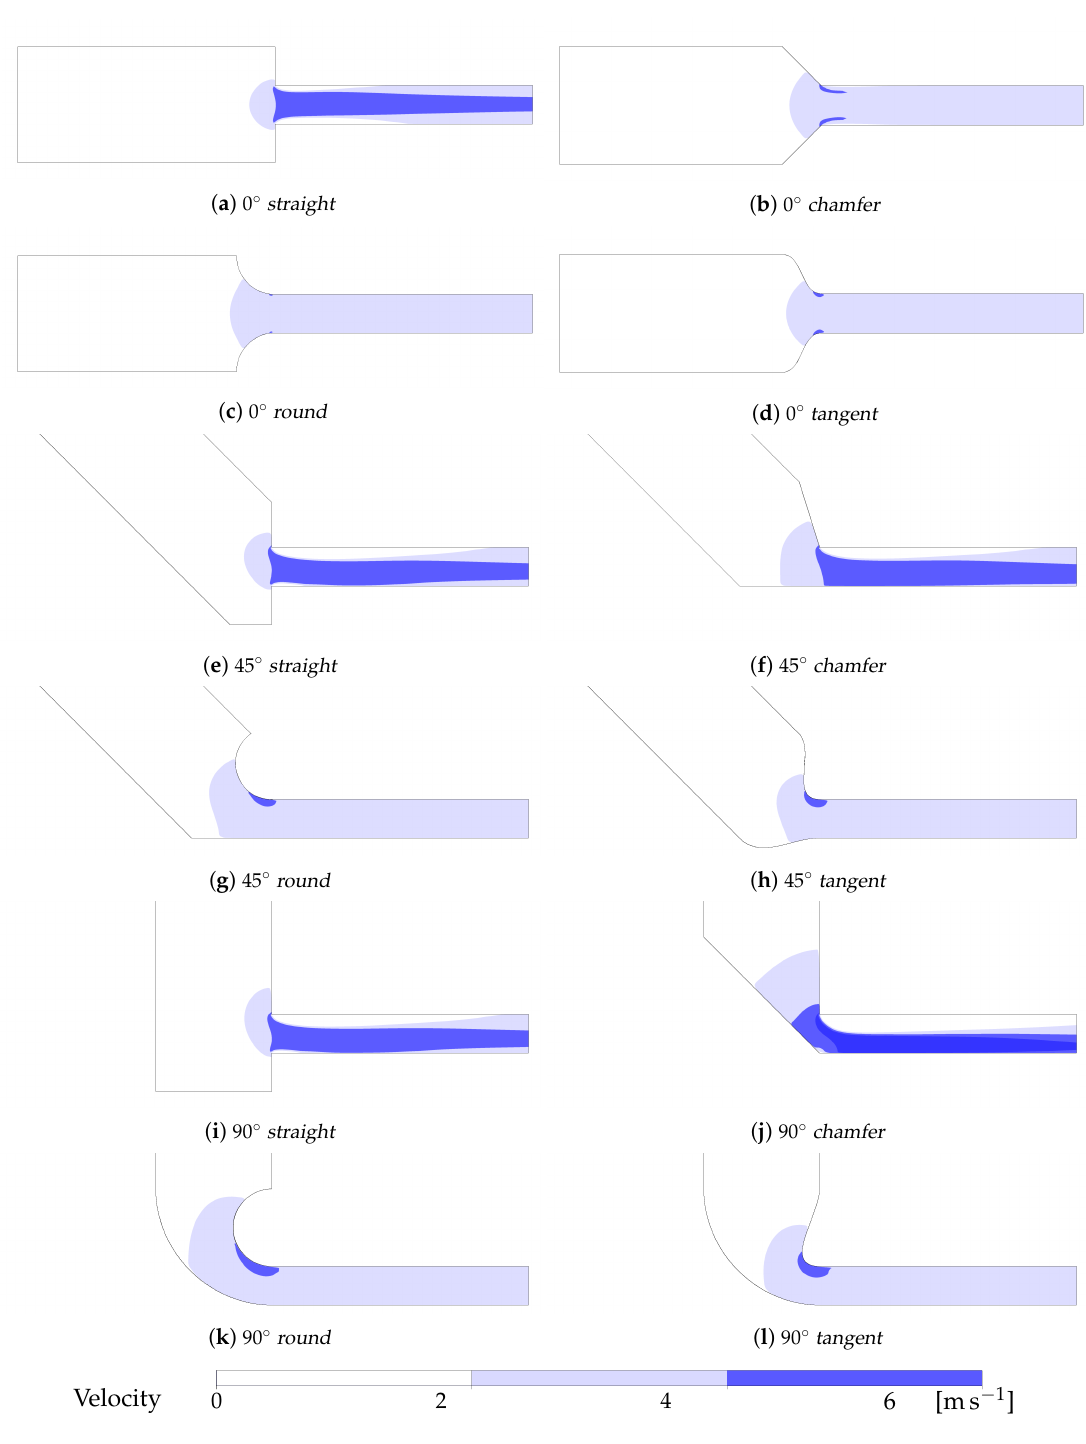
Figure 4. Comparison of different velocity